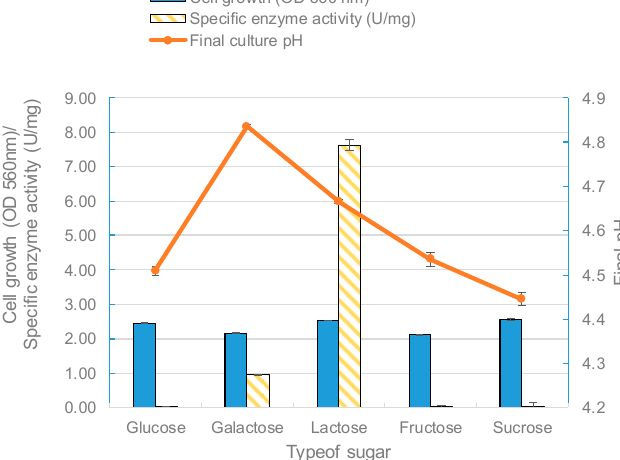
Figure 6. The effect of different carbon sources on the biomass, enzyme activity, and pH. The bacteria were grown statically (0 rpm) at 37 °C with different sole carbon sources (glucose, galactose, lactose, fructose, and sucrose) used at 2% ( w / v ) in 20 mL of modified MRS broth placed in 30 mL capacity universal media glass bottles. Results are shown as the mean ± standard deviation of three independent experiments.